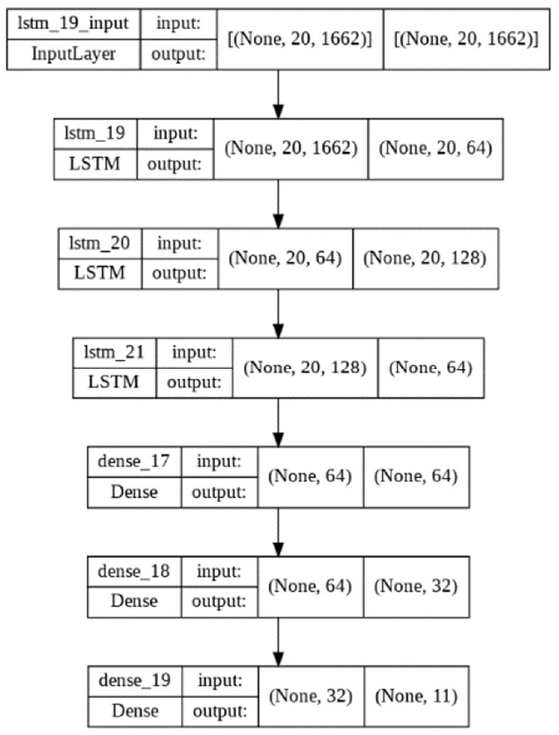
Figure 11. LSTM Architecture.